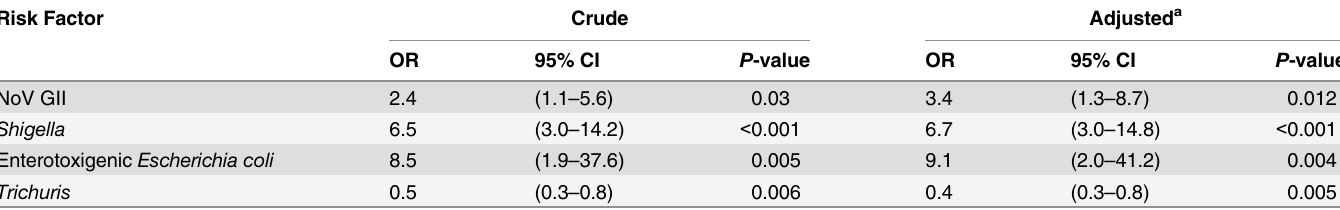
Table 2. Results of logistic regression analysis of pathogen with diarrhea as the outcome variable.